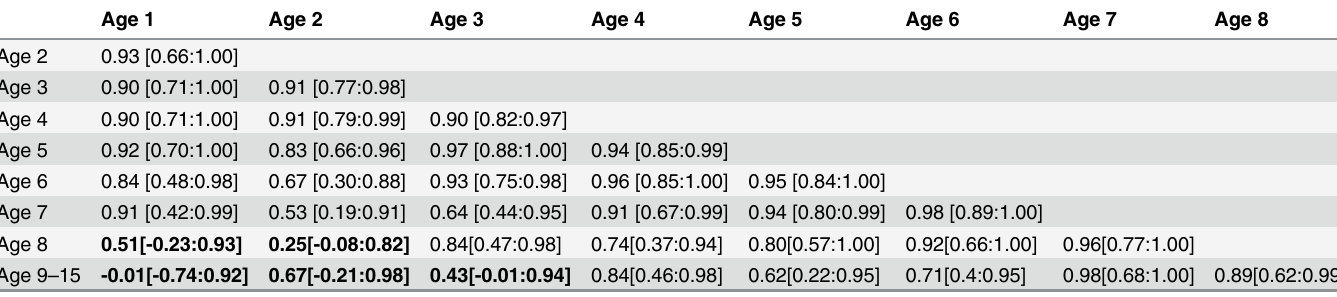
Table 8. Results of genetic correlations between age-classes for the number of eggs